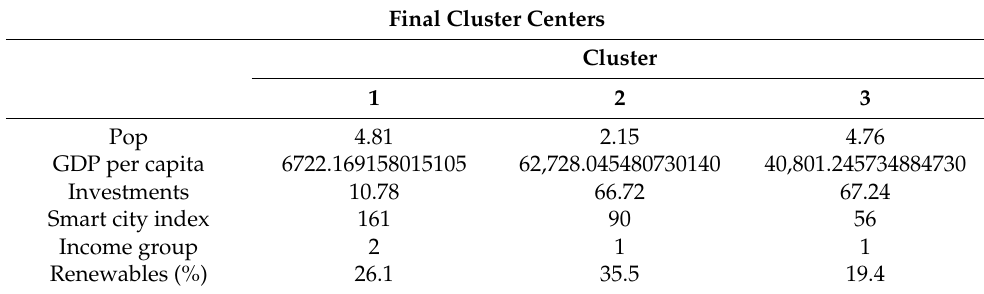
Table 5. Cluster averages, compiled by the authors.